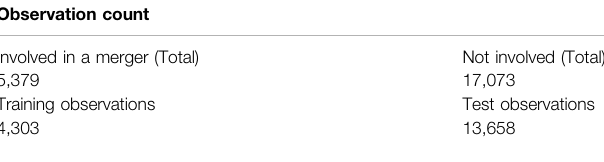
TABLE 1 | Observation count broken down, from years 2013 – 2017. Observation count Involved in a merger